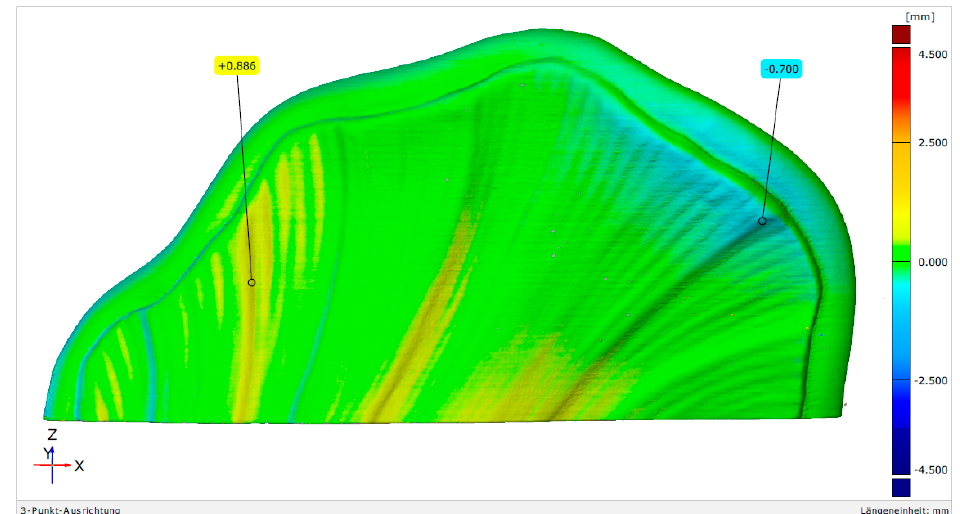
Figure 15. Superimposed fragment 3: manufacturing direction: alternating ( n = 2); solvent debinded.